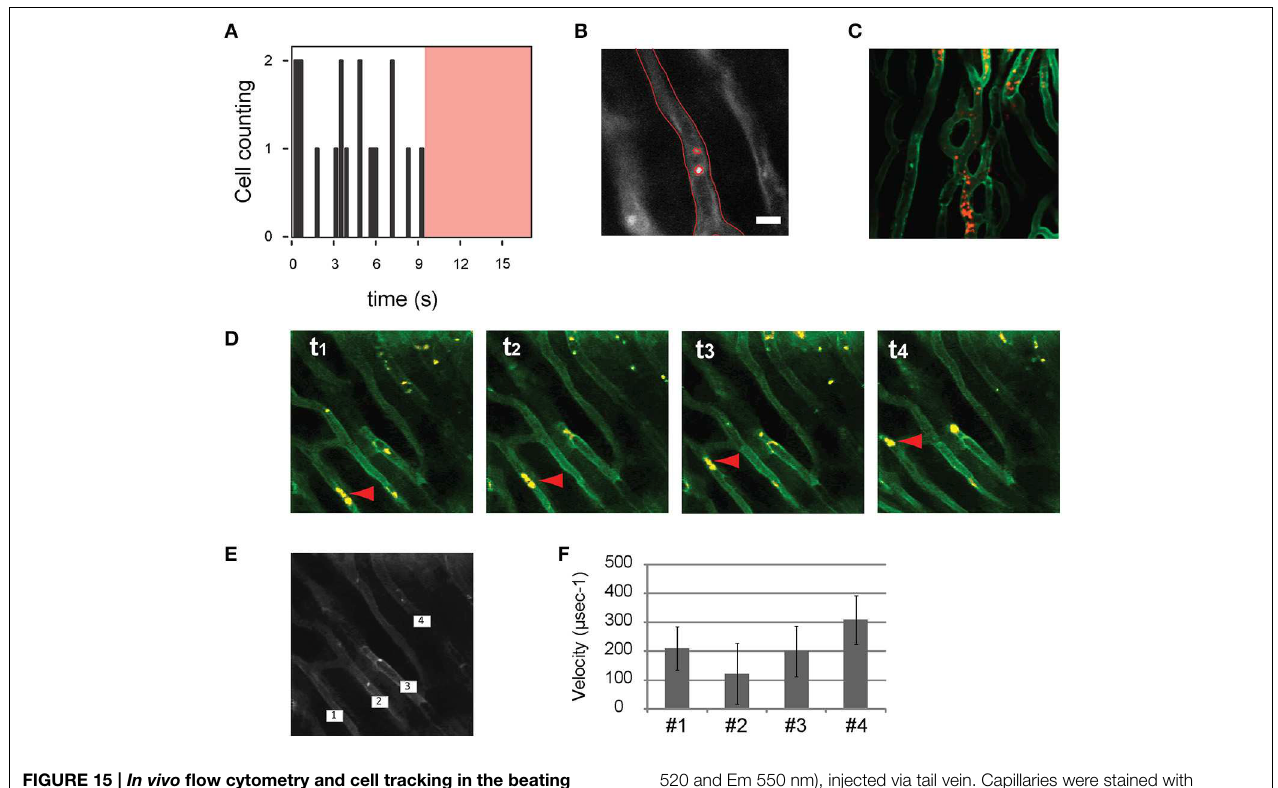
FIGURE 15 | In vivo flow cytometry and cell tracking in the beating heart. Images were acquired at 15 frames per second. (A) Number of leukocytes passing through the imaged capillary as a function of time within the region of interest indicated with a red border in (B) . In (A) the red shaded area indicates the time during which no leukocytes were transiting through the vessel. (B) Segmentation was performed to delineate the border of the vessel and the leukocytes. Leukocytes were stained with Rhodamine 6G (Ex